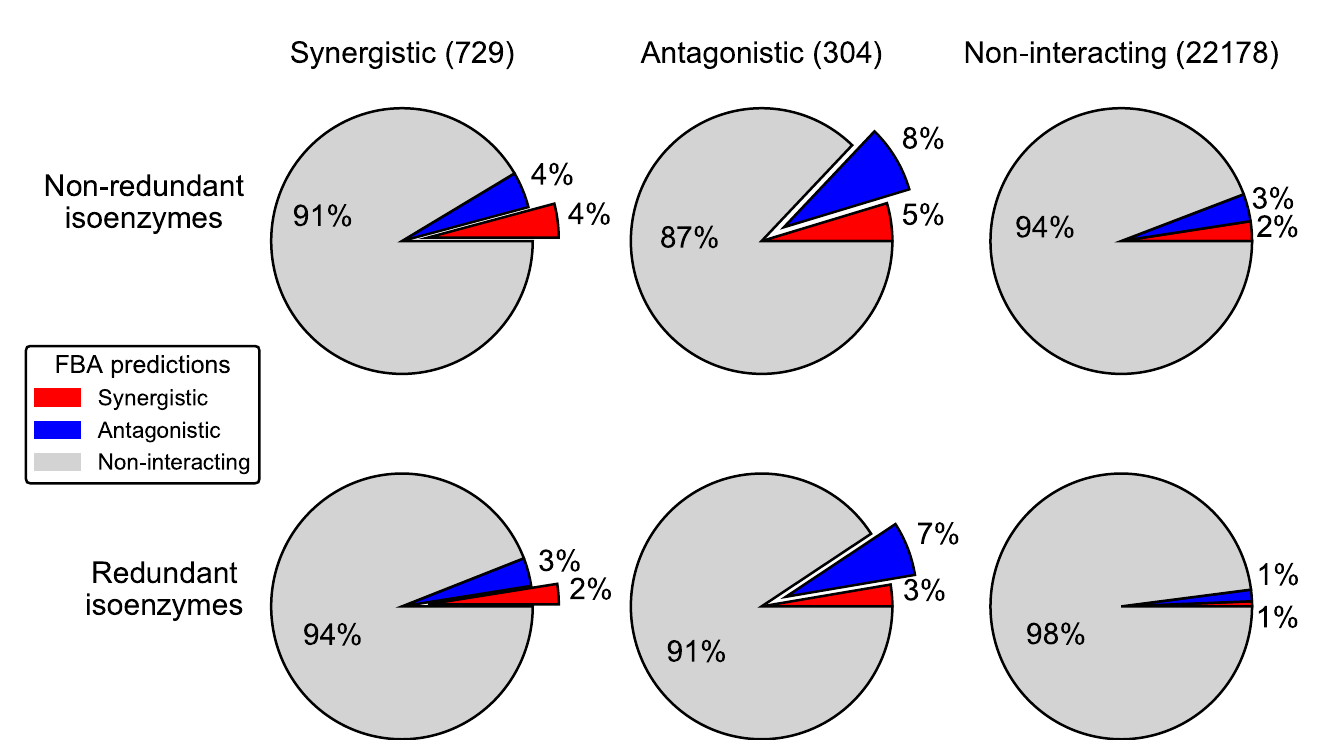
Fig 4. Comparison of correctly predicted epistatic interactions per gene. Each row represents one formulation of how isoenzymesmap to reactions in the FBA model: either the new assumptionthat isoenzymes are non-redundant and so knocking out any member of the isoenzyme set knocks out the reaction(top) or the standard assumption that all isoenzymes in a set needto be knocked out in order to knock out the corresponding reaction (bottom). Columns represent experimental classification of an epistatic interaction: synergistic (left), antagonistic (middle) and non- interacting(right). The total numberof these interactionsare listed at the top just below the headers. The pie chart in each sextant represents the capacity of FBA to predict these interactions. The colors of the slices show the FBA model predictions (blue, red and light grey, respectivelyfor synergistic, antagonistic and non-interacting). The offset slices show the correctly categorized genetic